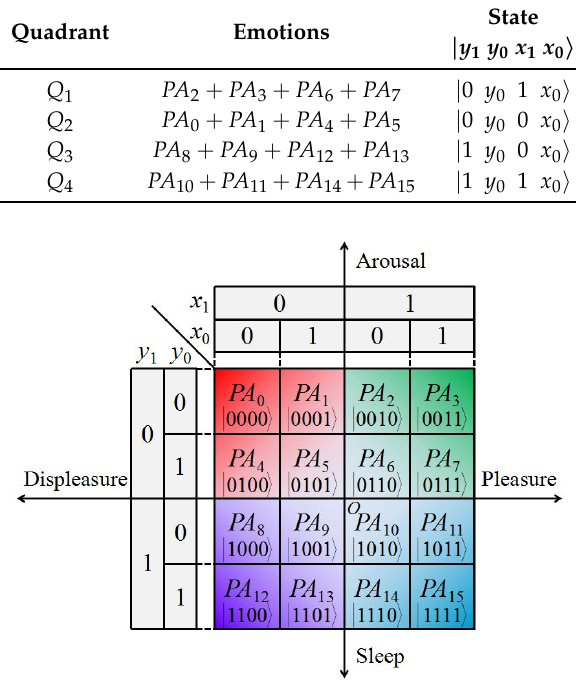
Table 1. Relationship between the quadrants and emotions.